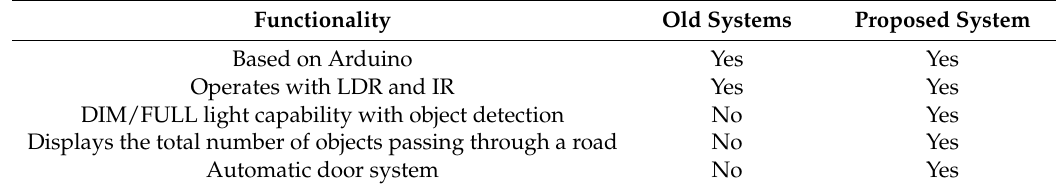
Figure 7. Result diagrams of enhanced work with an automatic door system and only an ON/OFF capability. ( a ) During a day/night-time simulation, the LEDs are not glowing. ( b ) Object in front of the first IR obstacle avoidance sensor; the HIGH LEDs are glowing. ( c ) Motion in front of the third IR obstacle avoidance sensor; the third set of LEDs are glowing. ( d ) An object detected is in front of the door, so it is automatically opened, and the relevant LEDs are glowing. Table 2. Comparison between old systems and the proposed system.